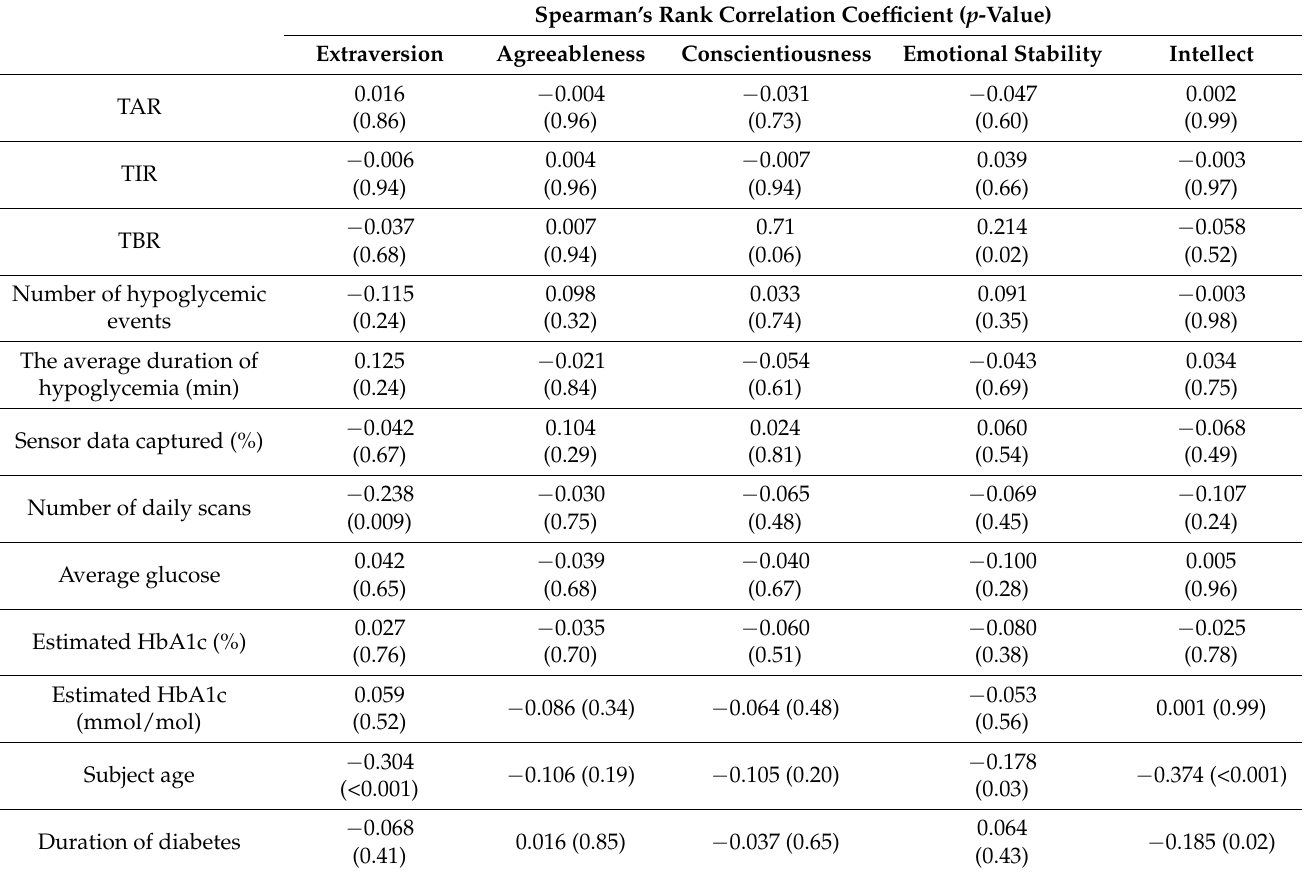
Table 10. Correlation of personality dimensions to Freestyle Libre glucose measurements and age.